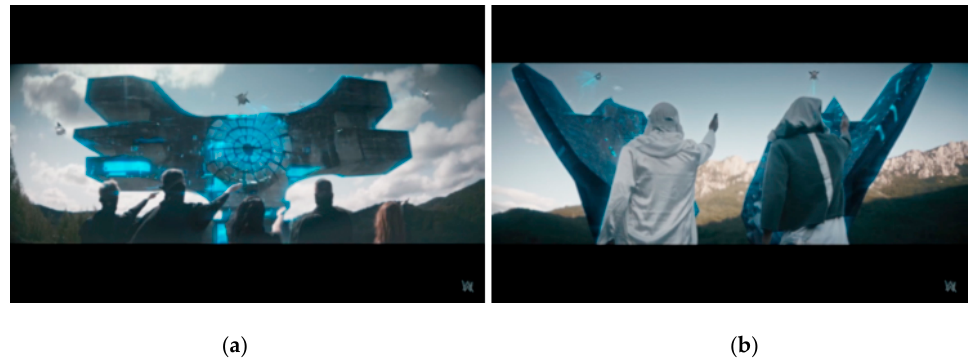
Figure 9. Sequences from the music video, “Darkside”, by Alan Walker, released in 2018, showing the Yugoslav monuments as a background for the futuristic music video. ( a ) Monument to the Revolution of the People of Moslavina, Podgari ć , Croatia; ( b ) The Battle of Sutjeska Memorial Monument Complex in the Valley of Heroes, Tjentište, Republic of Srpska, Bosnia amd Hercegovina. Screenshots, 2018-08-08. Source: https://www.youtube.com/watch?v=M-P4QBt-FWw.